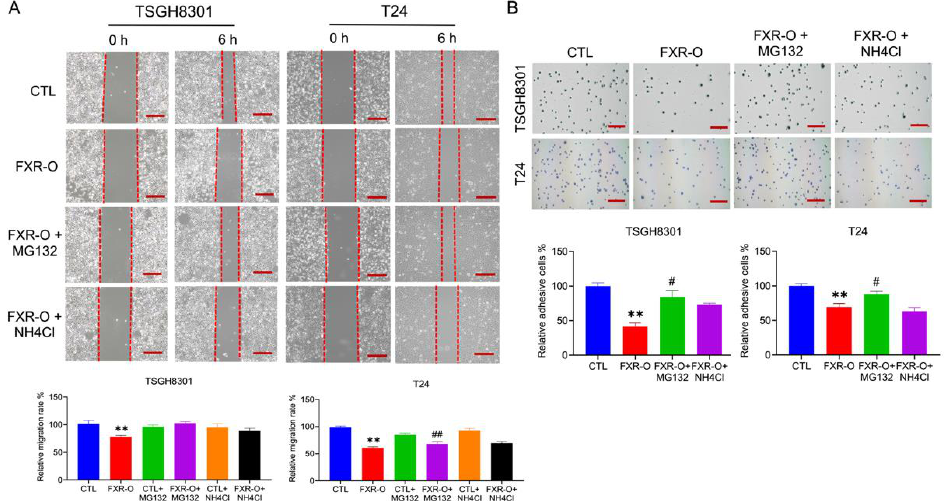
Figure 4. The effect of proteosome inhibitor MG132 and lysosome inhibitor NH4Cl on the migratory and adhesive abilities after FXR overexpression. ( A ) Wound healing migration assays were performed with or without MG132 or NH4Cl in TSGH8301 and T24 cells after 6 h scratch. The right panels displayed quantitative results of the relative migration rate. ** p < 0.01 compared to the control group; ## p < 0.01 compared to the FXR-O group. ( B ) Adhesion assays were performed in TSGH8301 and T24 cells for 50 min. The cells were stained and captured. The right panels displayed quantitative results of the relative adhesive rate. ** p < 0.01 compared to the control group; # p < 0.05 compared to the FXR-O group. Scale bar = 200 μm.